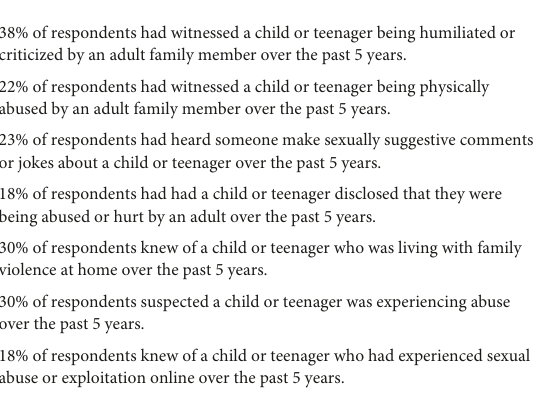
TABLE 8 Key findings. TABLE 9 Reaction to the becoming aware of the